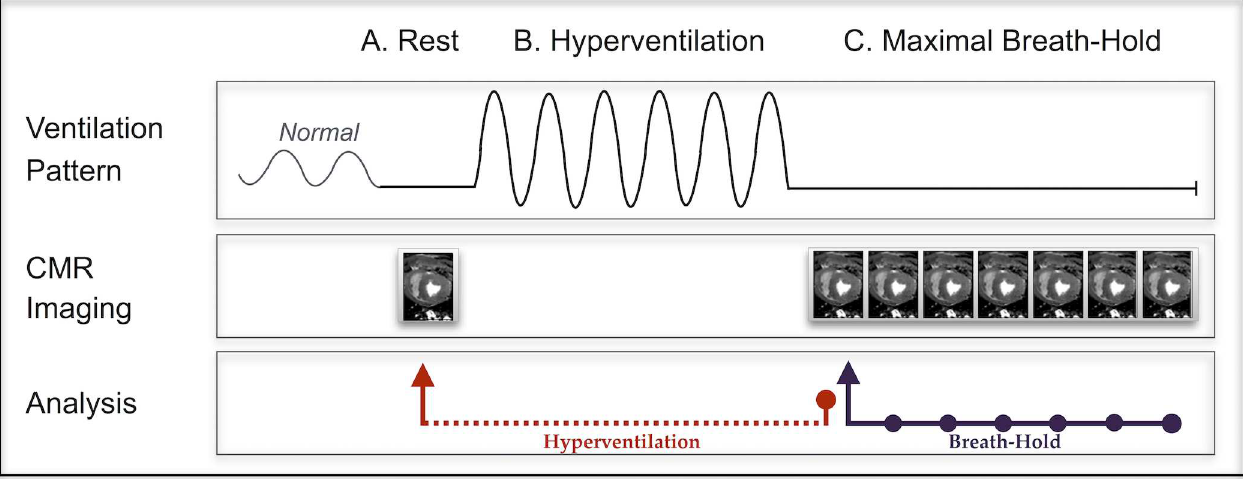
Fig 2. Breathing maneuver protocol. For the combinedhyperventilation breath-hold (HVBH) maneuver, a single rest measurement was obtained in a short breath-hold (A). The animalwas then manuallyhyperventilated for 60s (B) followedimmediately by a long breath-hold (C) that was imaged throughout, with a repeatingOS sequence.Hyperventilation analysis was always comparedbetween rest and the start of the breath- hold (red arrow), while the breath-hold could be analyzedat multiple time points with comparisonto data obtainedat the beginning of the breath- hold (purple arrow). The long breath-hold (LBH) followedstep C, starting after a normal ventilation